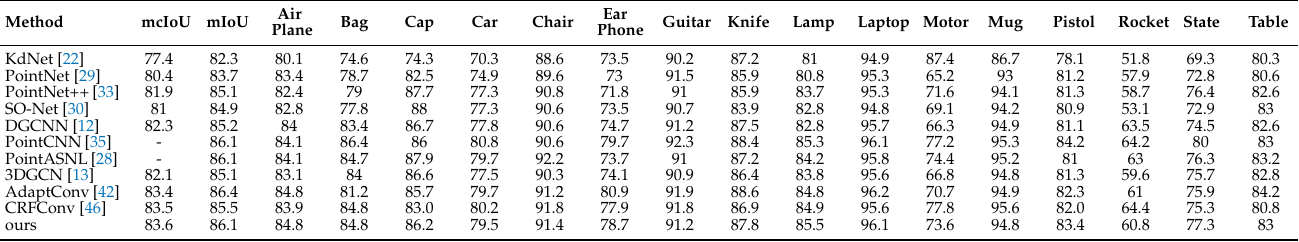
Table 2. Part segmentation results on the ShapeNetPart dataset evaluated as the mean class IoU (mcIoU ( % ) ) and mean instance IoU (mIoU ( % )